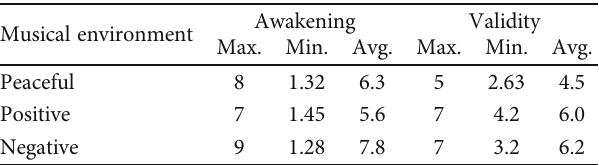
Table 3: Arousal and potency statistics collated. Musical